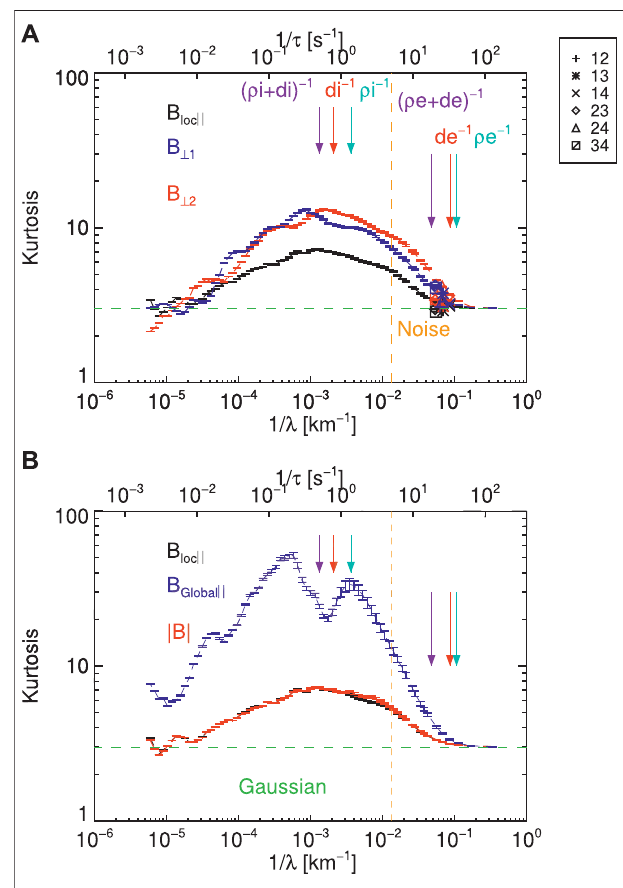
FIGURE 4 | (A) The scale-dependent kurtosis for the magnetic fi eld components in a local mean- fi eld co-ordinate system. The connected lines denote the time-lagged increments and the points denote the spatially lagged values. (B) Three different measures of the compressible magnetic fi eld component. Blue denotes the global mean fi eld over the entire interval, red denotesthemagnitudeofthemagnetic fi eldandblackdenotesthesamelocal mean- fi eld as in (A) . The green horizontal line denotes a kurtosis of 3 which corresponds to a Gaussian distribution. The orange vertical line denotes 5 Hz where instrumental noise becomes signi fi cant in the fl uxgate magnetometer data. The colored arrows denote the characteristic ion scales the cyclotron scale, the inertial length and the Larmor